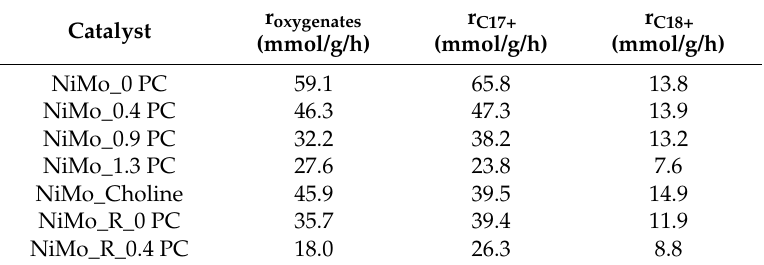
Figure 3. Effect of phospholipid (PC) on the HDO of oleic acid at 54 bar and 320 ◦ C using 0.3 mL DMDS; ( a ) oxygenates conversion, ( b ) yield of C17+, ( c ) yield of C18+. Table 1. Initial rates of oxygenates and alkane formation measured at 1 h.